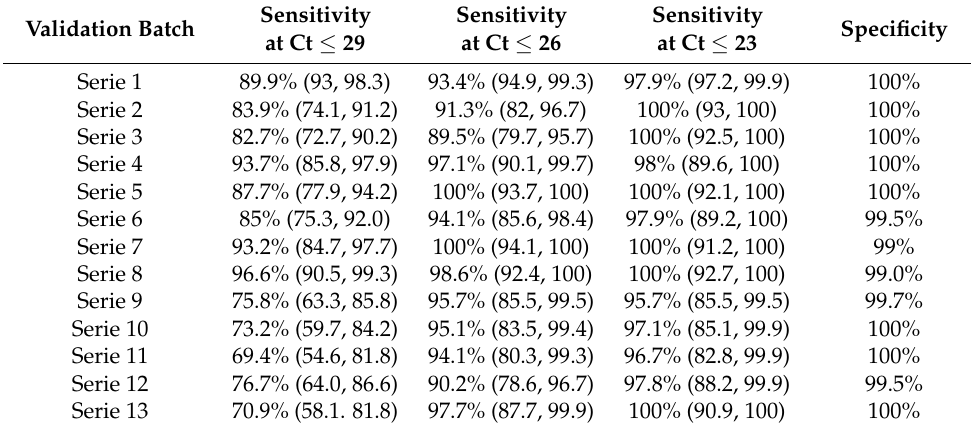
Table 3. Sensitivity and specificity rates of Standard Q ® , stratified according to the viral load, along all batches of validation. Numbers in brackets indicate the 95% confidence